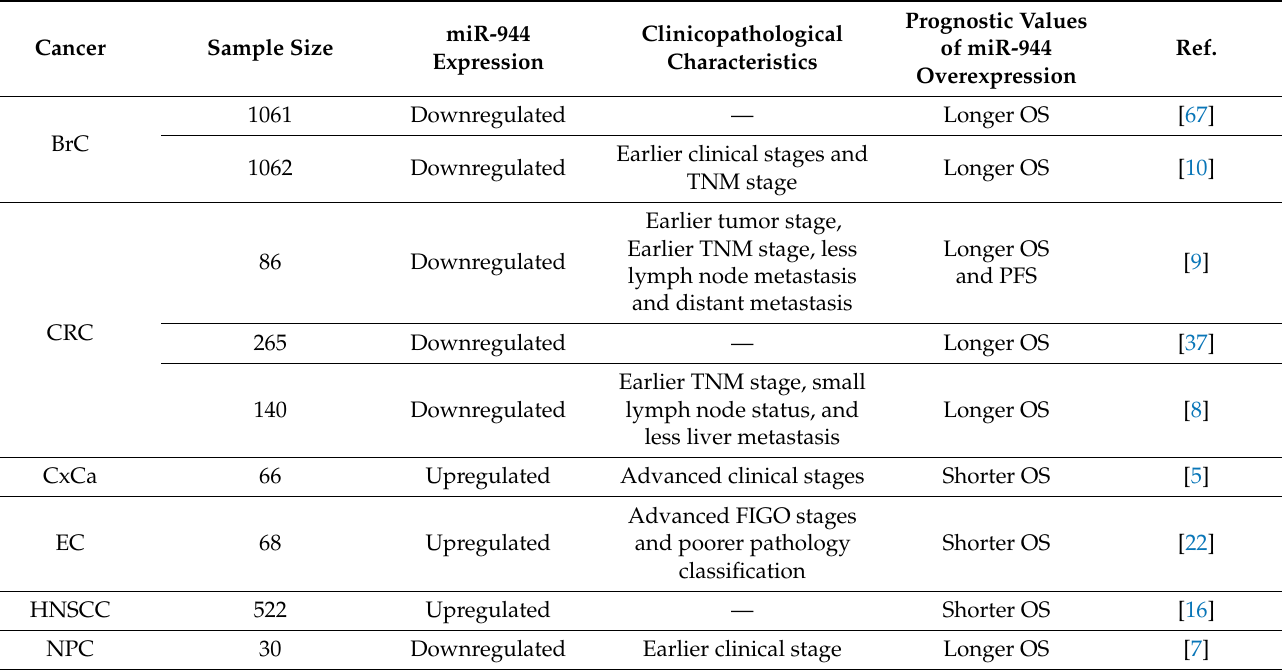
Table 5. Prognostic values of